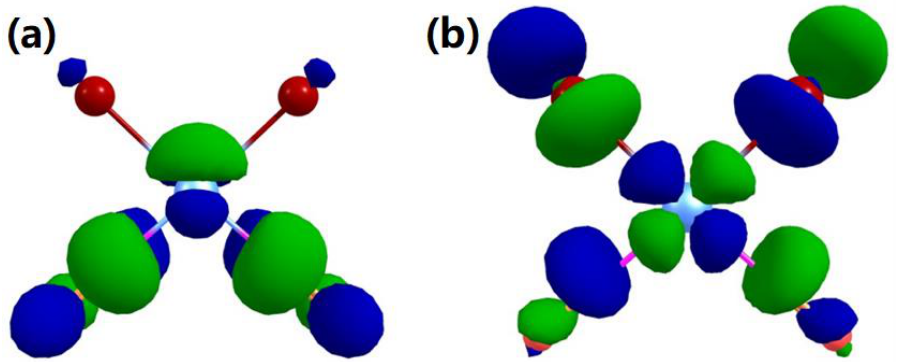
Figure 3. Isosurfaces of the frontier orbitals of the Pt(CO) 2 Br 2 anion obtained with a contour value of 0.05. ( a ): SOMO. ( b ): SOMO+1.